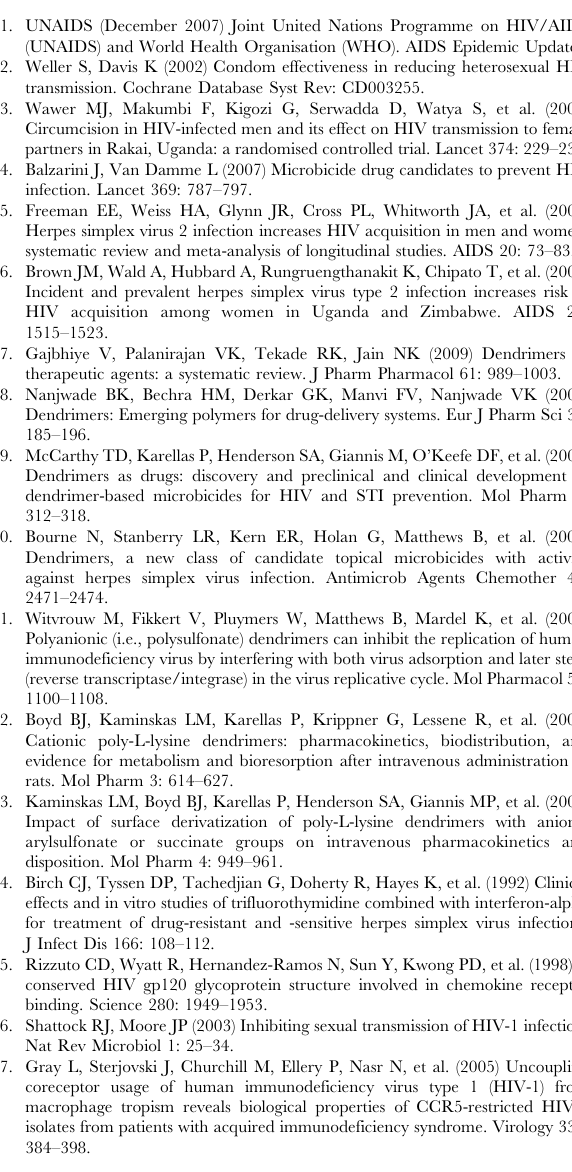
Table S4 SPL7013 is active against a multi-drug resistant HIV-1 strain in